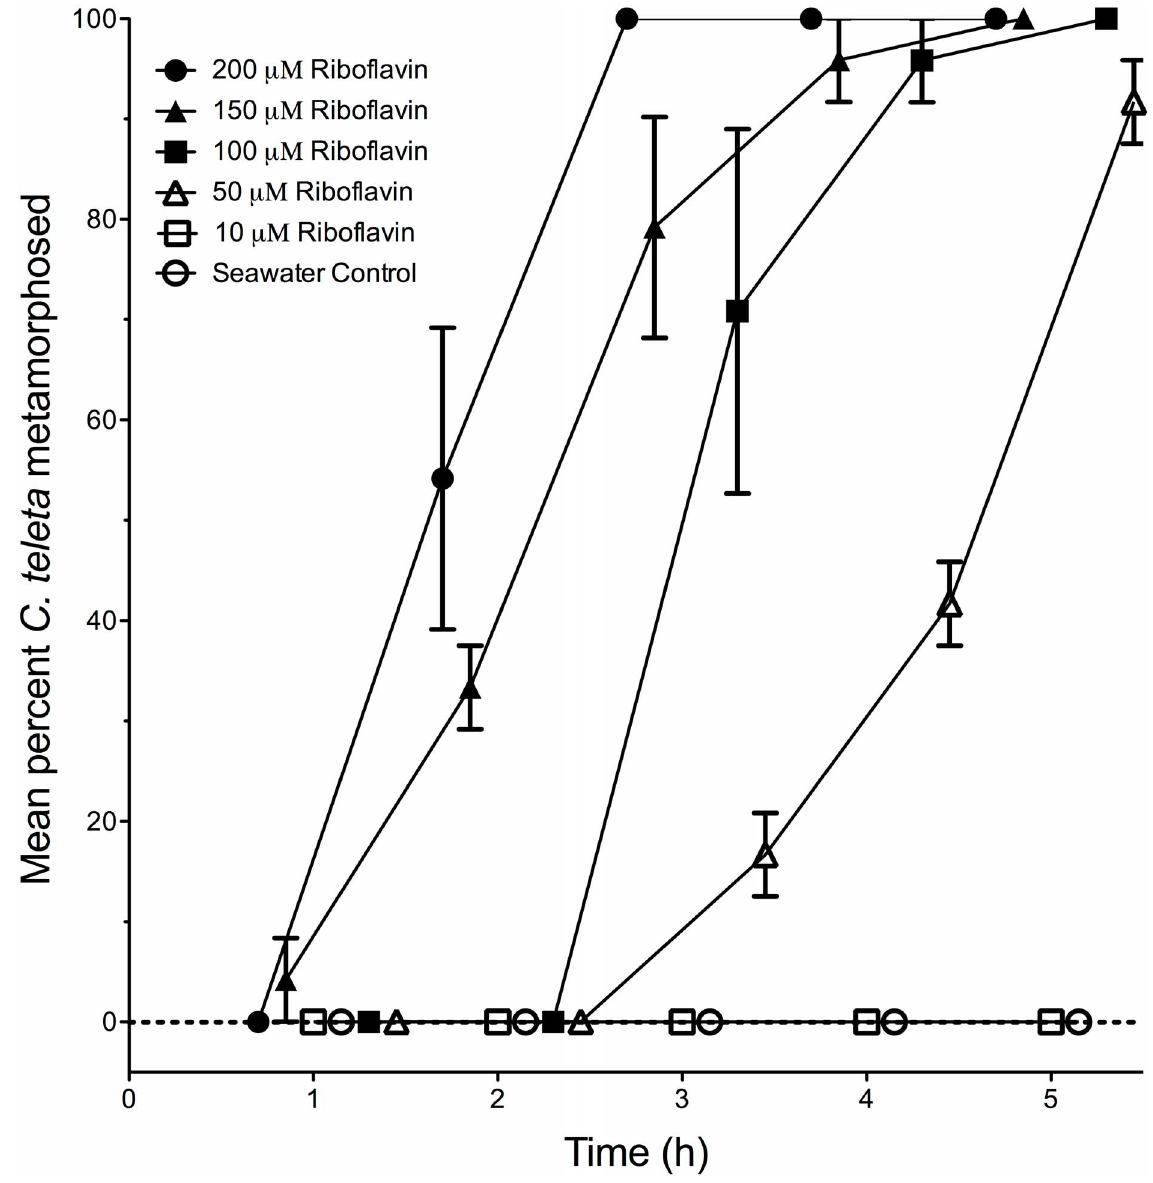
Figure 2. Promotion of metamorphosis by riboflavin (vitamin B 2 ) in larvae of Capitellateleta . Each treatment consisted of 3 replicates with 8 larvae per replicate. Larvae were placed in 30 ppt artificial seawater (Instant Ocean) containing the indicated final concentration of riboflavin. Artificial seawater acted as a negative control. Error bars represent + / 2 1 s.e.m.